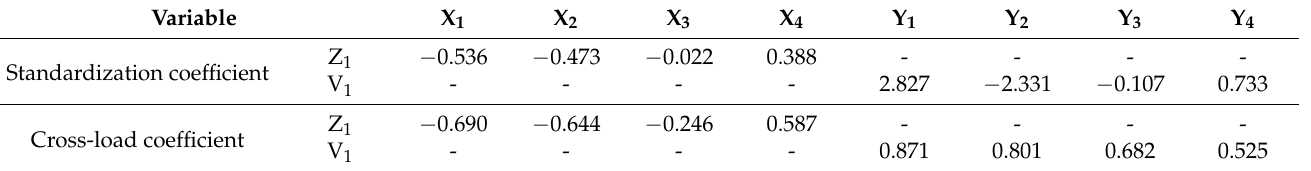
Table 4. Standardization coefficient and cross-load coefficient of typical